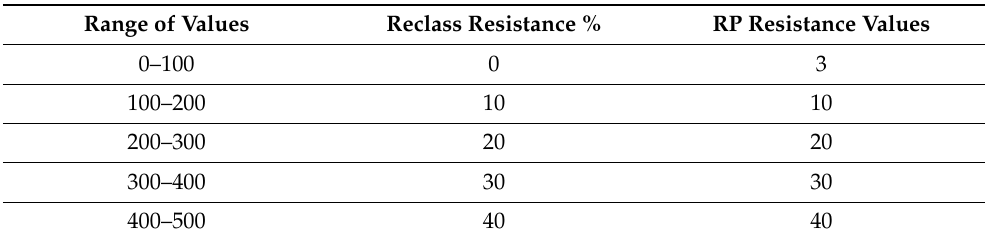
Table A3. Restoration planner (RP) input values for resistance values derived from Corine Land Cover 2018’s land use classes and average daily traffic of infrastructures of the study